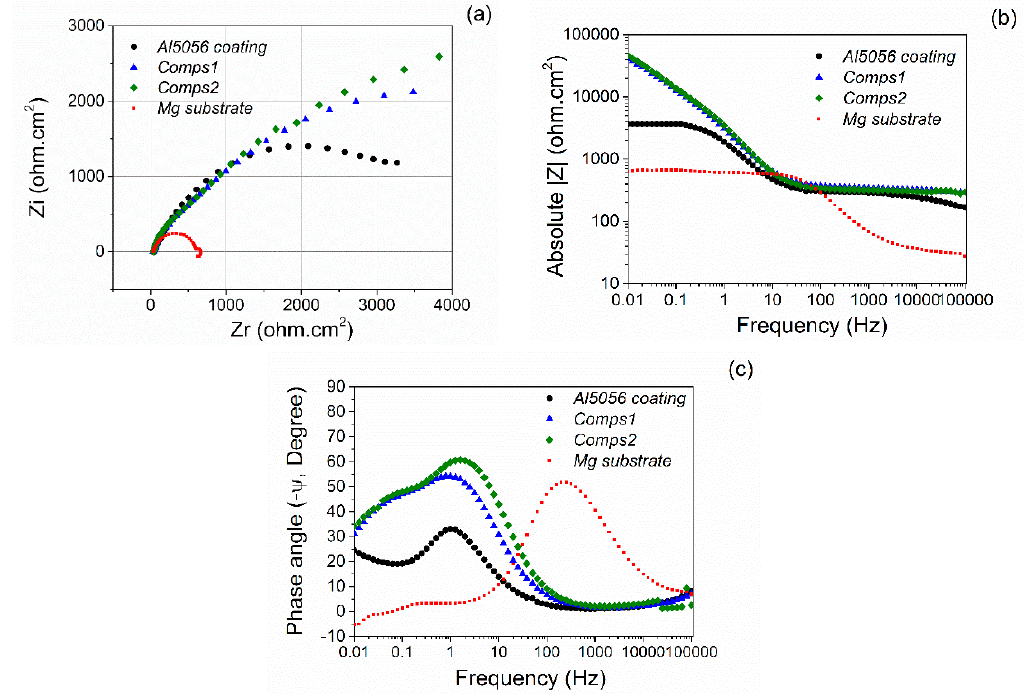
Figure 7. Electrochemical impedance spectroscopy (EIS) results obtained from the cold-sprayed Al 5056 coating, SiC p /Al 5056 composite coatings and magnesium substrate: ( a ) Nyquist spectra and ( b ), ( c ) Bode plots.